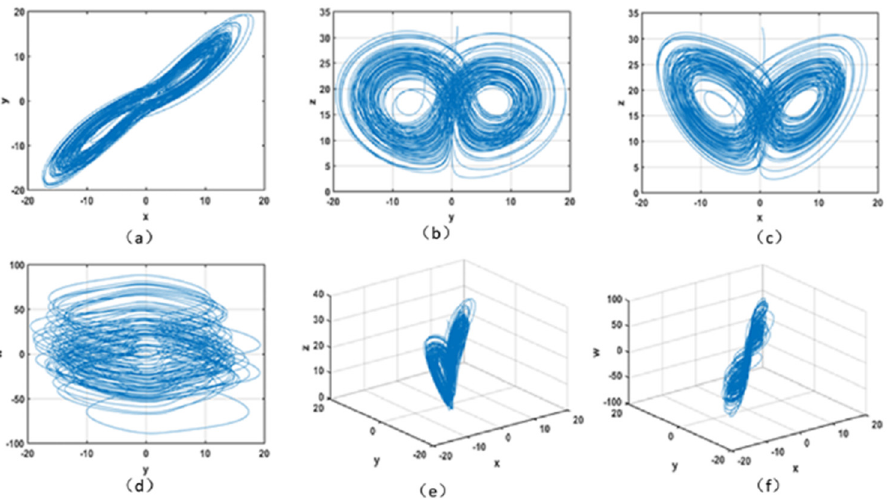
Figure 1. The phase diagram of the proposed hyper-chaotic system: ( a ) x–y phase diagram; ( b ) x–z phase diagram; ( c ) y–z phase diagram; ( d ) y–w phase diagram; ( e ) x–y–z phase diagram; ( f ) x–y–w phase diagram.